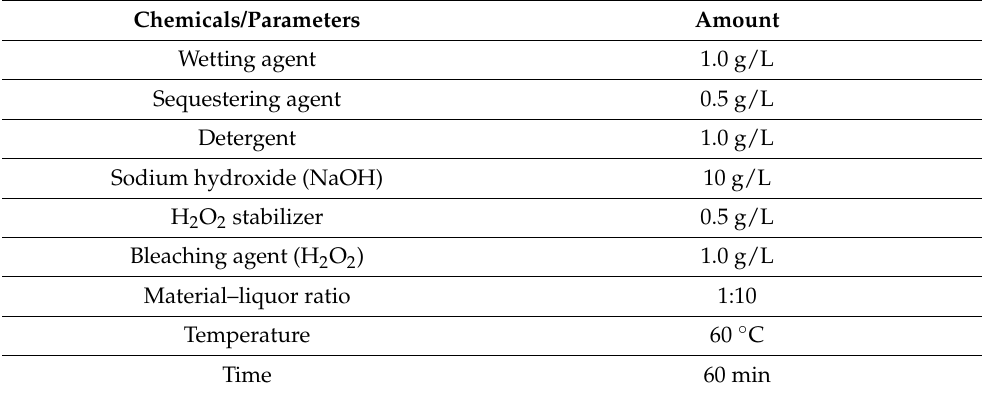
Table 3. Recipe for combined NaOH and H 2 O 2 treatment of the raw fabric.